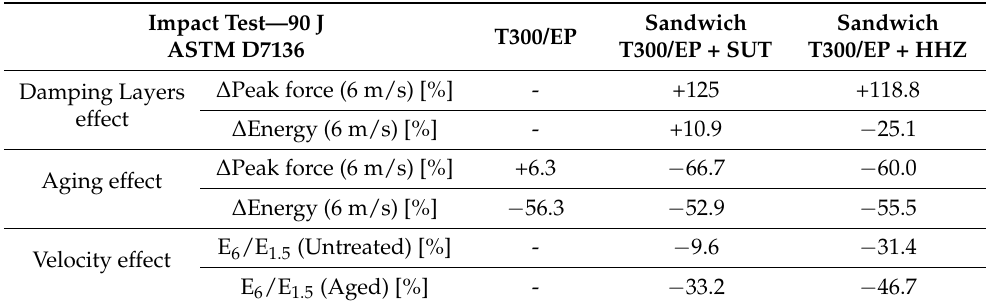
Table 5. Relative variation of the impact performance, considering the effects of: damping, aging, and velocity.